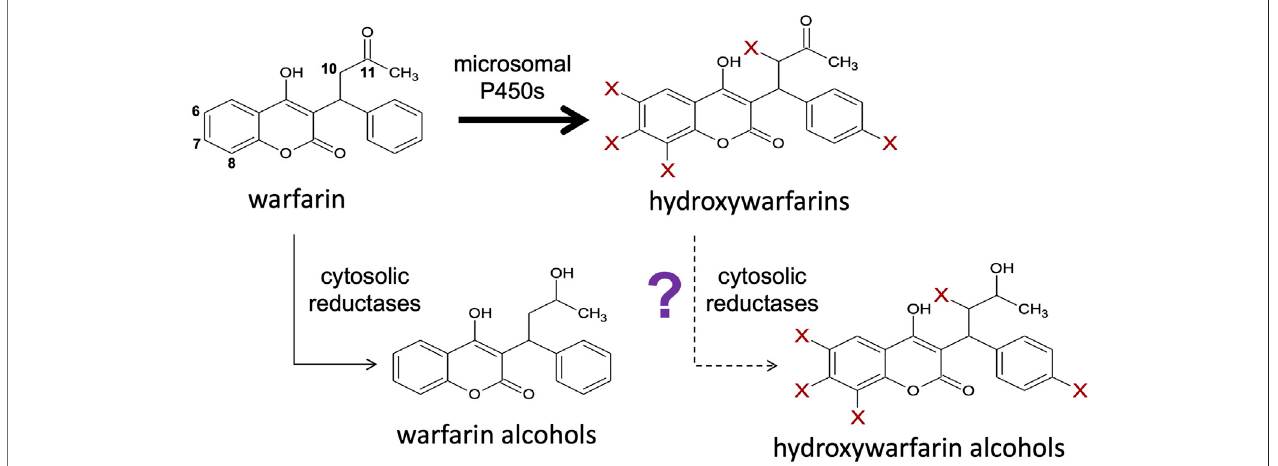
FIGURE1| Hydroxywarfarinsarethepredominantmetabolitesofwarfarinmetabolismthatmaybeclearedthroughanovelcarbonylreductionpathway.Warfarinis directly metabolized via a major pathway by membrane-bound cytochromes P450 to form hydroxywarfarins and a minor pathway by cytosolic reductases to form warfarinalcohols(KaminskyandZhang1997;JonesandMiller2011).Furtherreductionofthehydroxywarfarinmajormetabolitesbyreductasestoformhydroxywarfarin alcohols may also be possible as a secondary reaction.